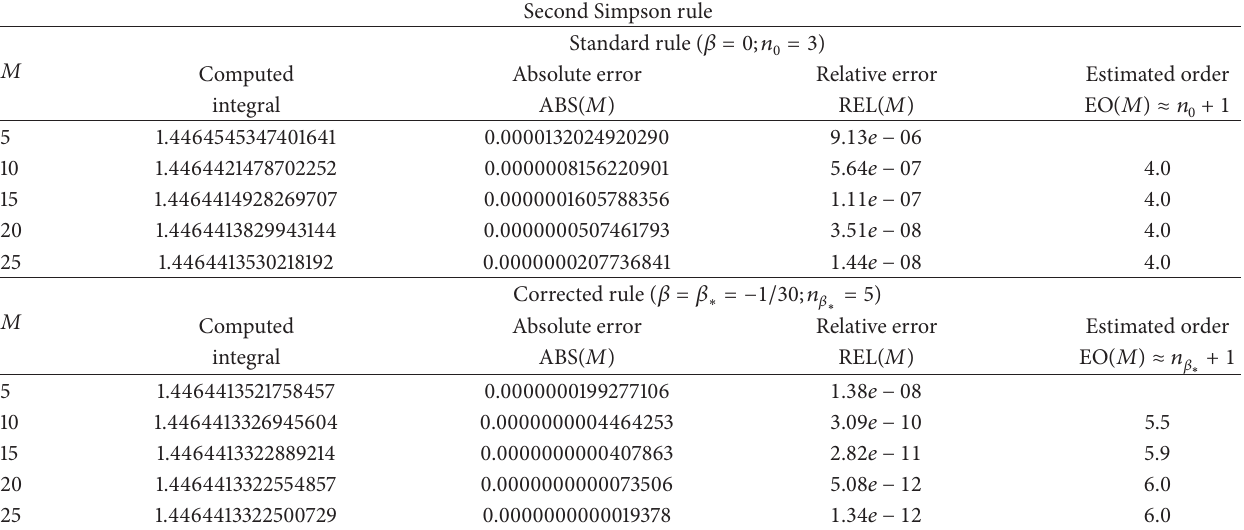
Table 7: Results for the second Simpson